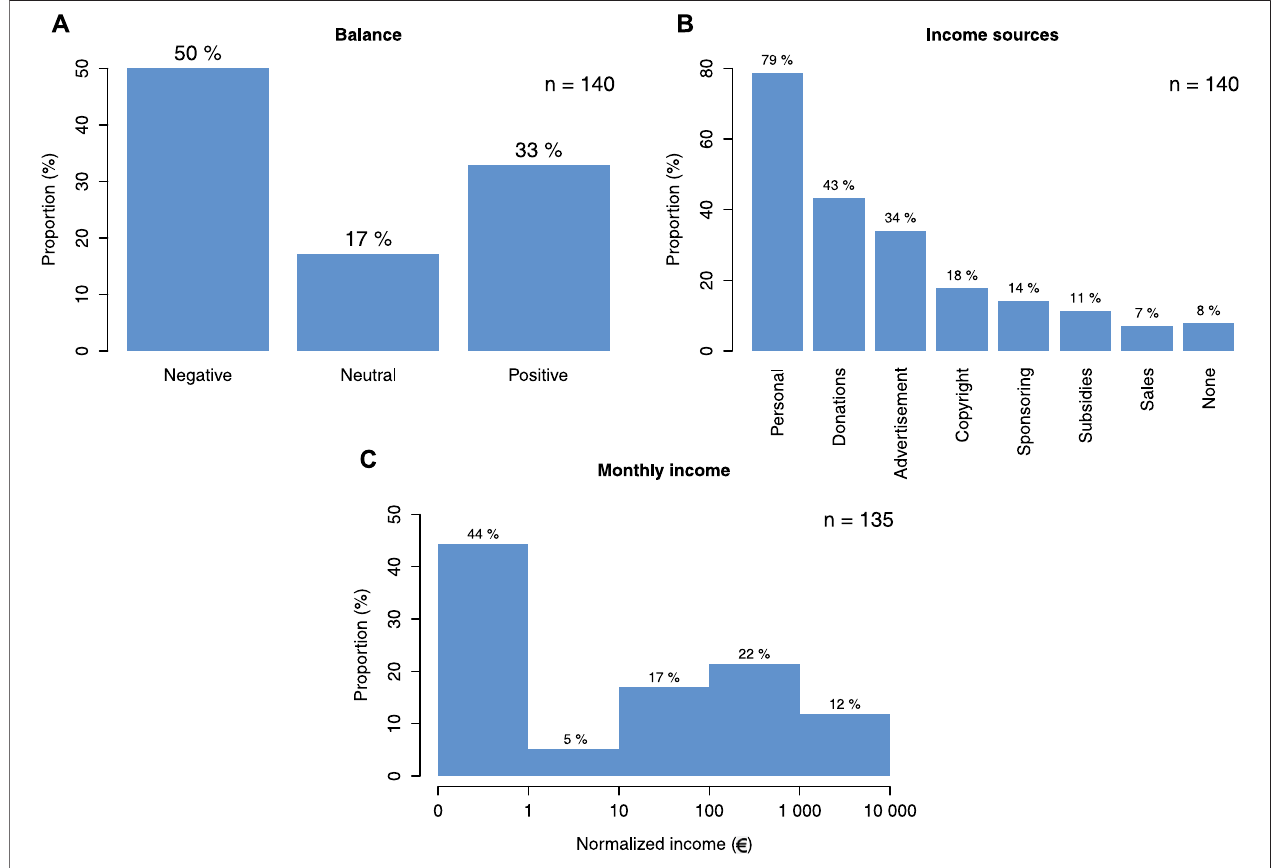
FIGURE 2 | Financial situation of channels managed by individual communicators. (A) Overall channel balance (i.e., whether the channel made its owner earn money or lose money overall since its creation). (B) Percentage ofindividual communicators reporting a speci fi cincome source (C) Monthly income(in euros) divided by the number of people working on the